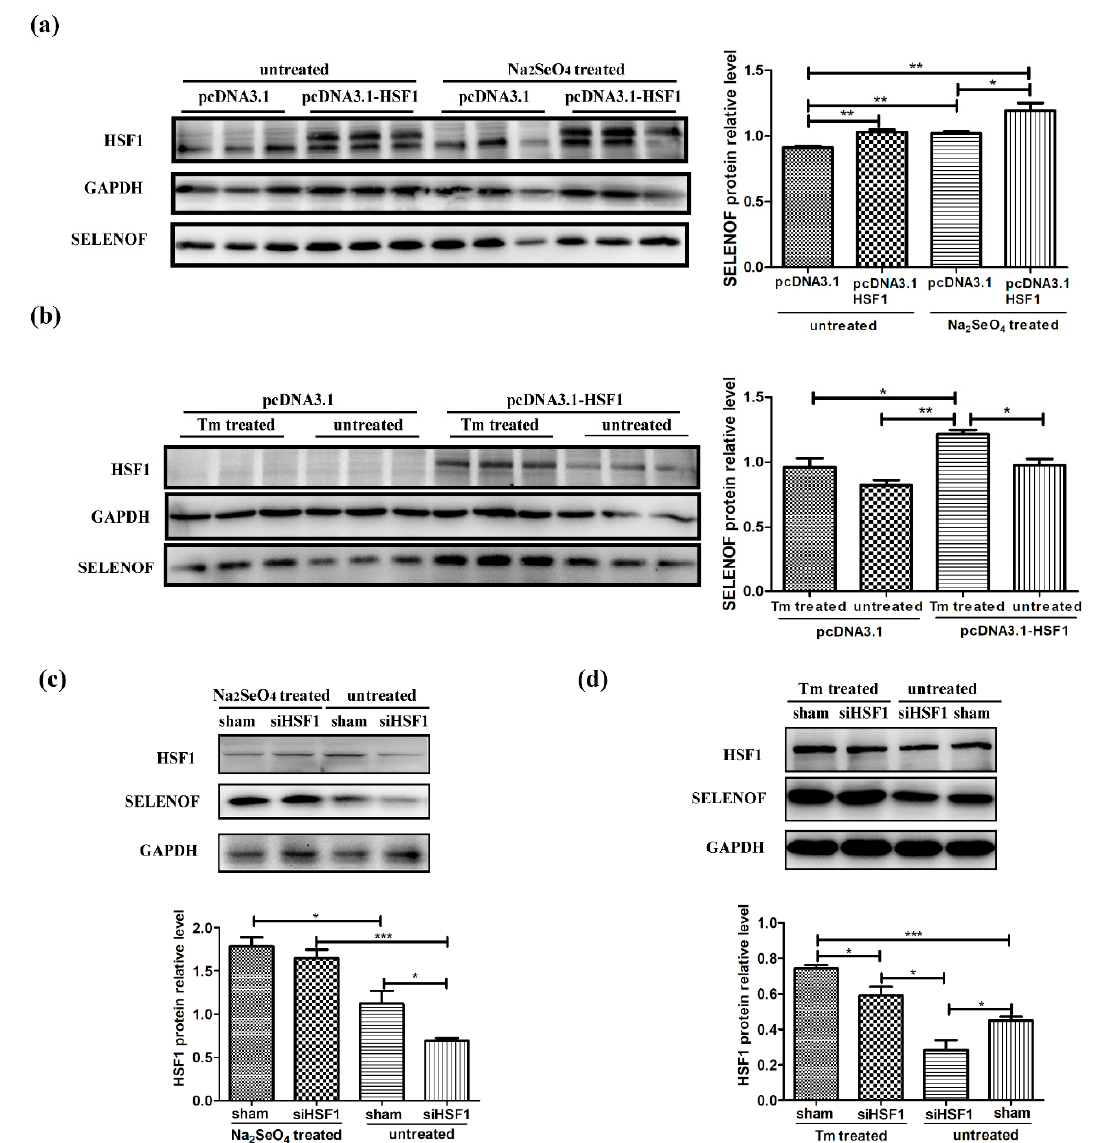
Figure 8. Involvement of HSF1 in the up-regulation of SELENOF during selenate and Tm treatment. Protein levels of SELENOF in ( a ) control and HSF1 over-expressed HEK293T cells with / without selenate treatment, ( b ) control and HSF1 over-expressed HEK293T cells with / without Tm treatment, ( c ) siRNA transfected HEK293T cells with / without selenate treatment, and ( d ) siRNA transfected HEK293T cells with / without Tm treatment. The data are representative of three independent experiments. The sham siRNAs were used as negative control to be compared with the siHSF1 siRNAs. * p < 0.05, ** p < 0.01 and *** p < 0.001.